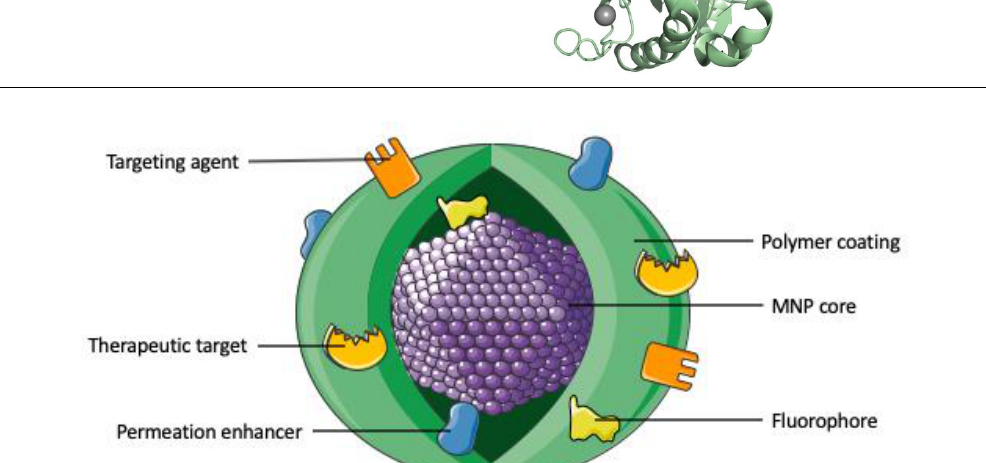
Figure 2. Magnetic nanoparticle coated with a surface coating and functional groups chosen for specific uses, e.g., targeting agents, permeation enhancers or fluorophores.